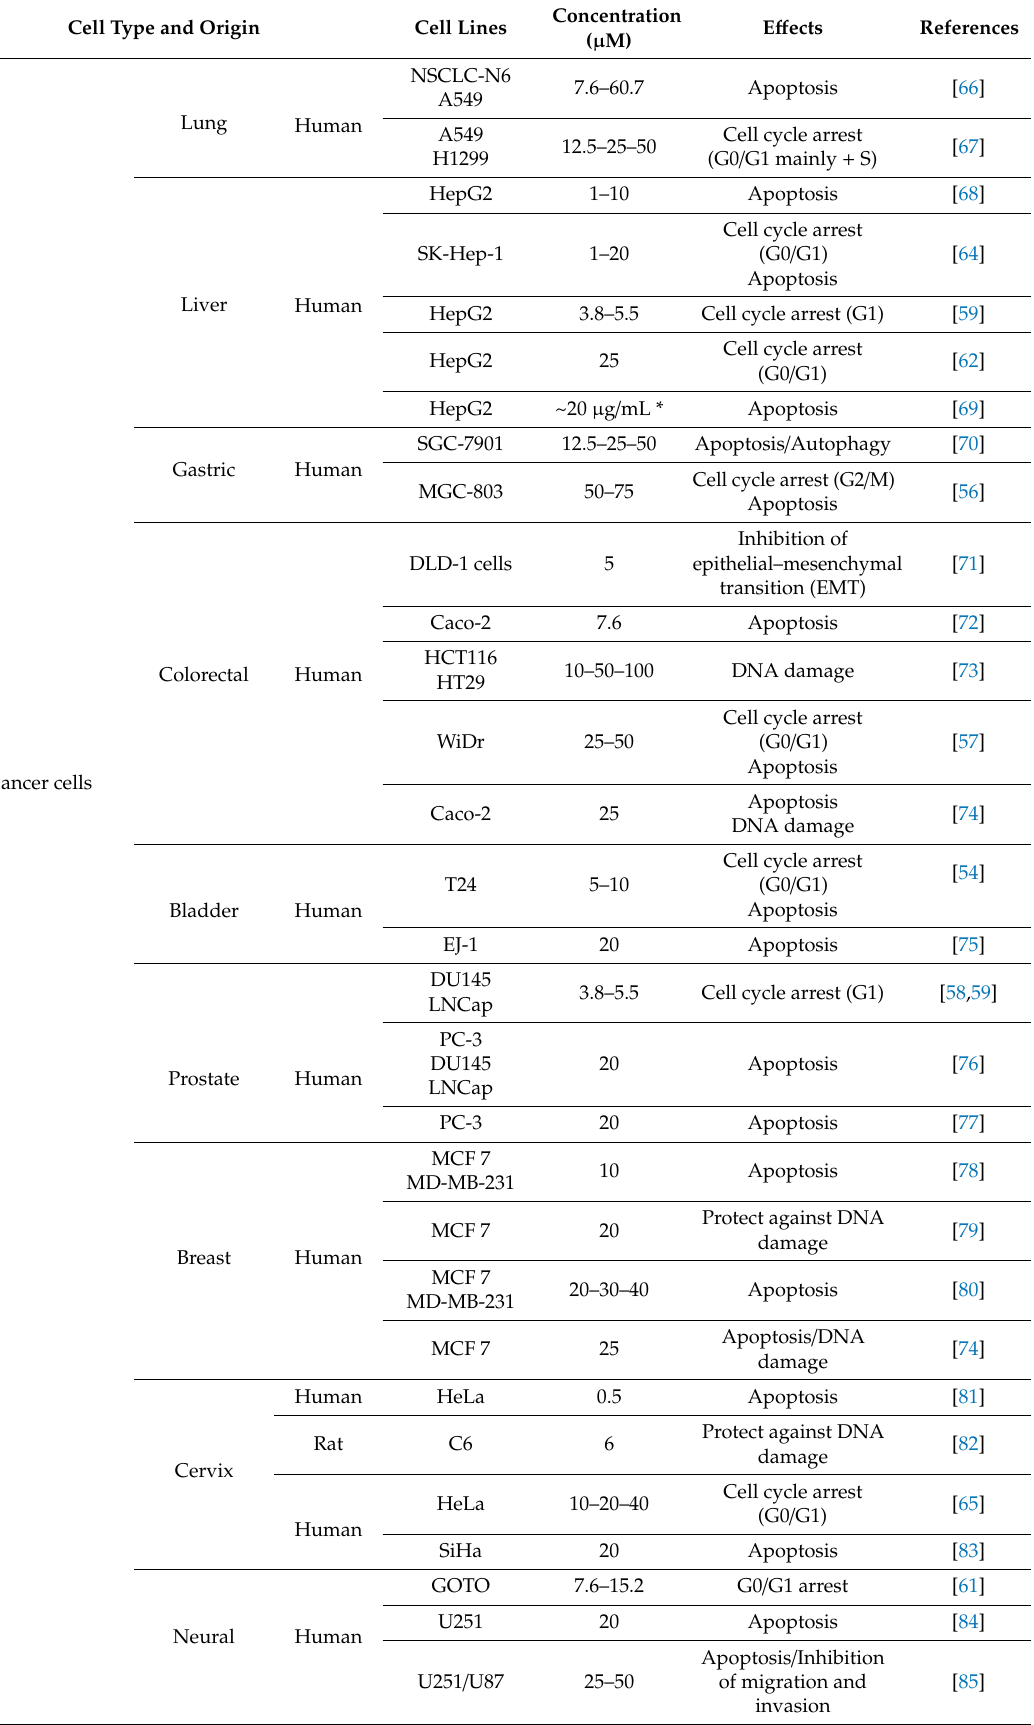
Table 2. In vitro e ff ects of fucoxanthin on cancer and non-cancer